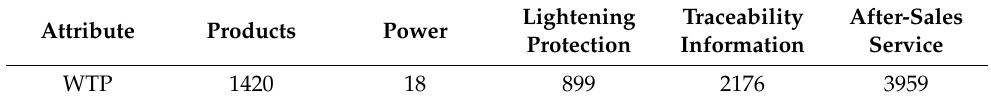
Table 8. The calculation